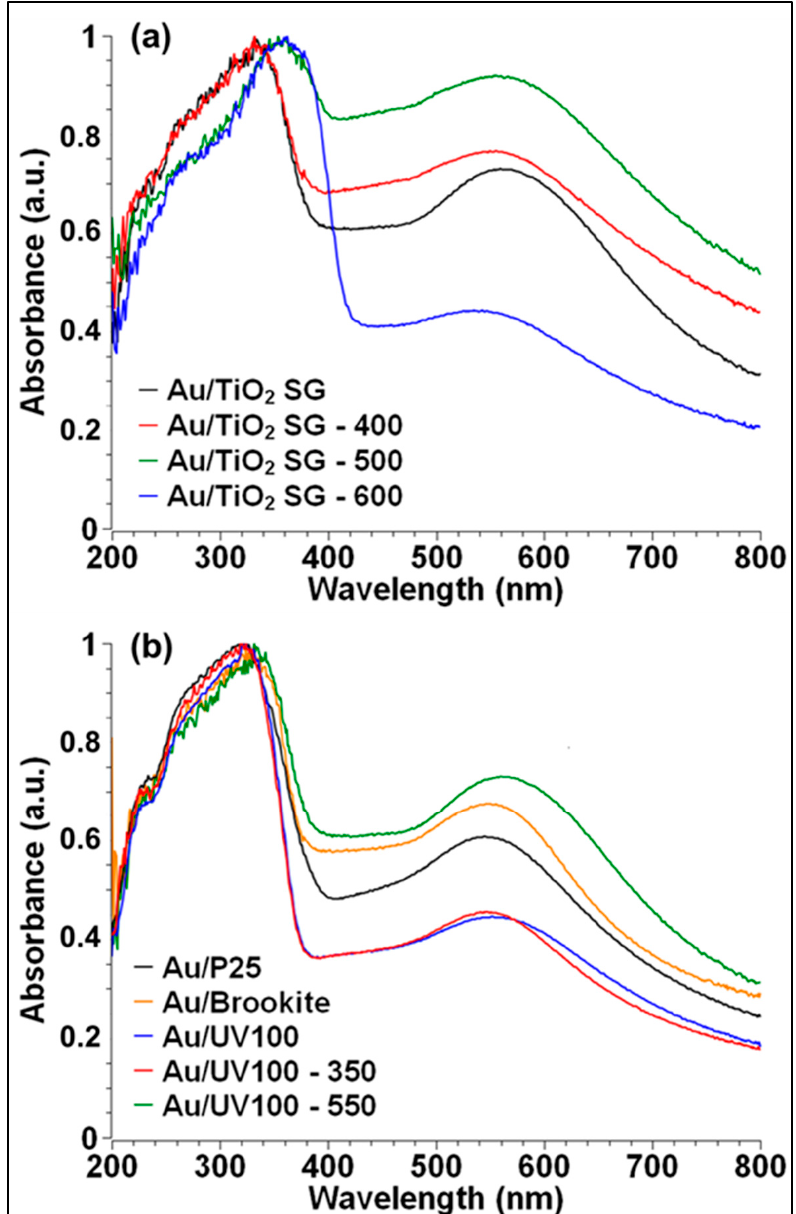
Figure 4. UV-Visible spectra of ( a ) Au/TiO 2 SG – X and ( b ) Au/TiO 2 P25, Au/TiO 2 Brookite and Au/TiO 2 UV-100 – X commercial-based samples.